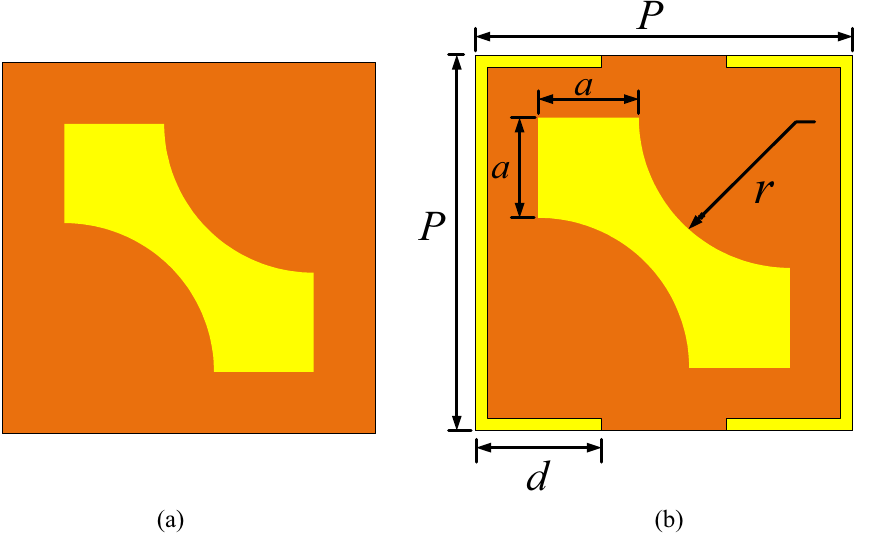
Figure 1. Geometry of the proposed single layer converter, ( a ) without SRR, ( b ) with SRR (figures are extracted from CST microwave Studio software version